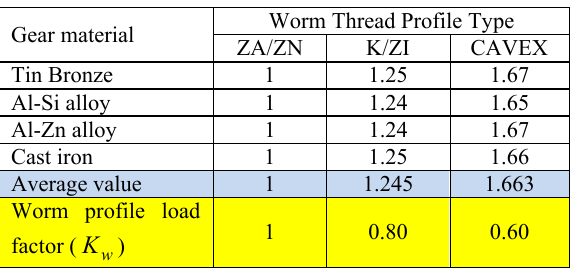
Table B2: Worm Profile Load Factor ( K w